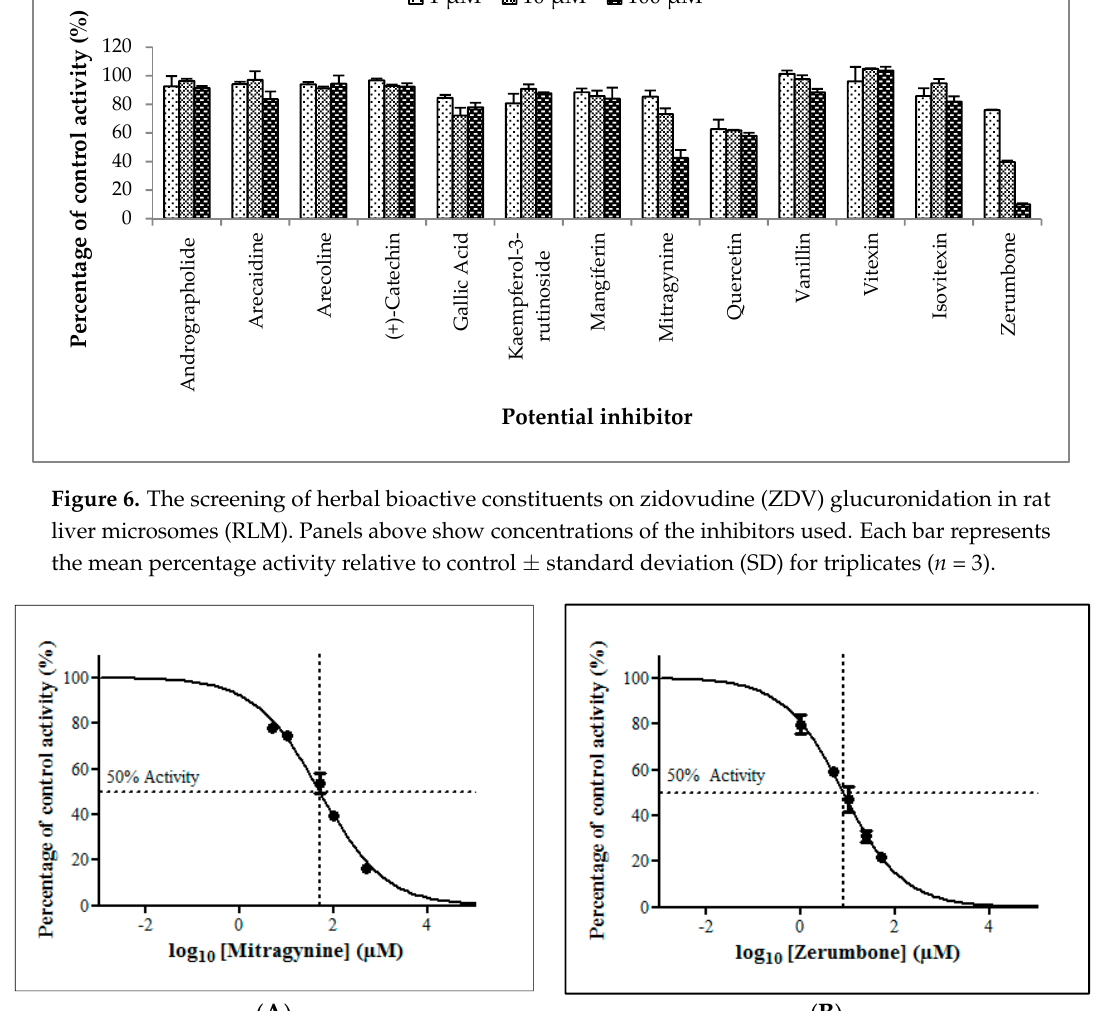
Figure 7. The inhibitory effect of ( A ) mitragynine and ( B ) zerumbone on zidovudine (ZDV)